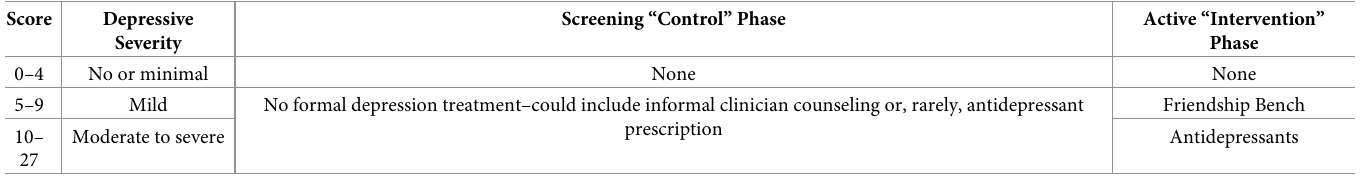
Table 1. Depression treatment overview, by